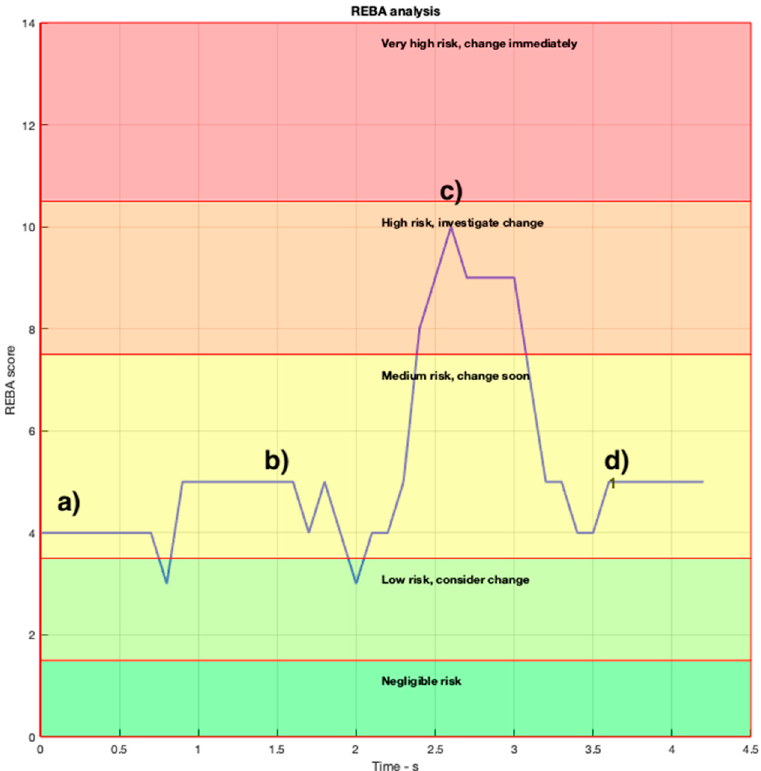
Figure 7. REBA scores of the OTP. The instants corresponding to the four snapshots in Figure 6 are indicated from ( a – d ).